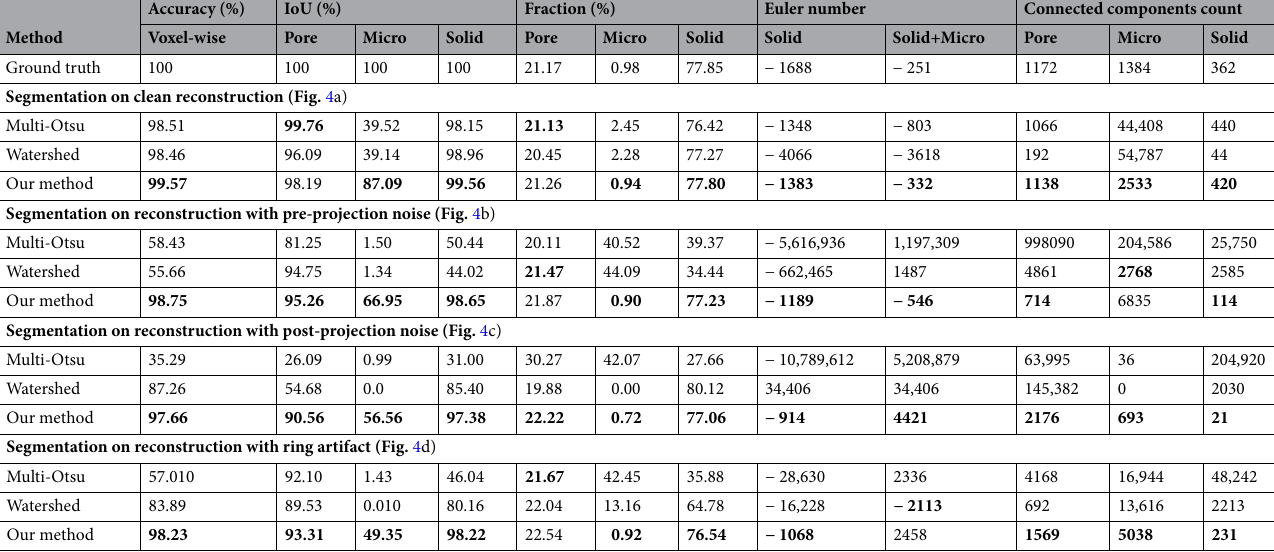
Table 2. Comparison of our model and traditional segmentation methods for several synthetic cases: (a) no noise, (b) pre-projection noise, (c) post-projection noise, and (d) ring artifacts. The closer the values to the ground truth the better. Bold values indicate the closest value to the ground truth in each category.